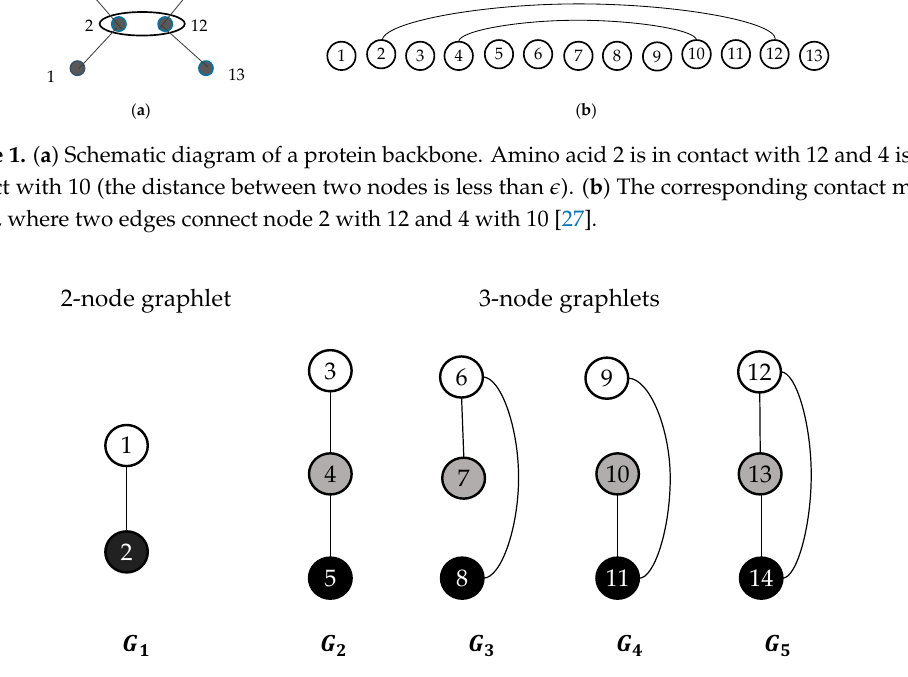
Figure 2. The five 2-node and 3-node ordered graphlets and the corresponding 14 automorphism orbits. The ordering of the graphlet nodes in each graphlet G i , i ∈ { 1, . . . ,5} is represented by their colors: white nodes <gray nodes<black nodes [27].